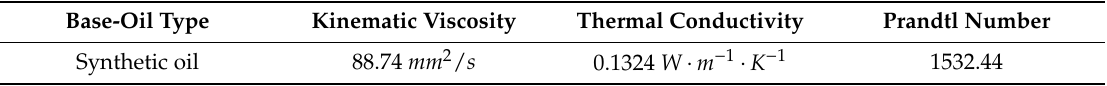
Table 4. Performance parameters of lubricant